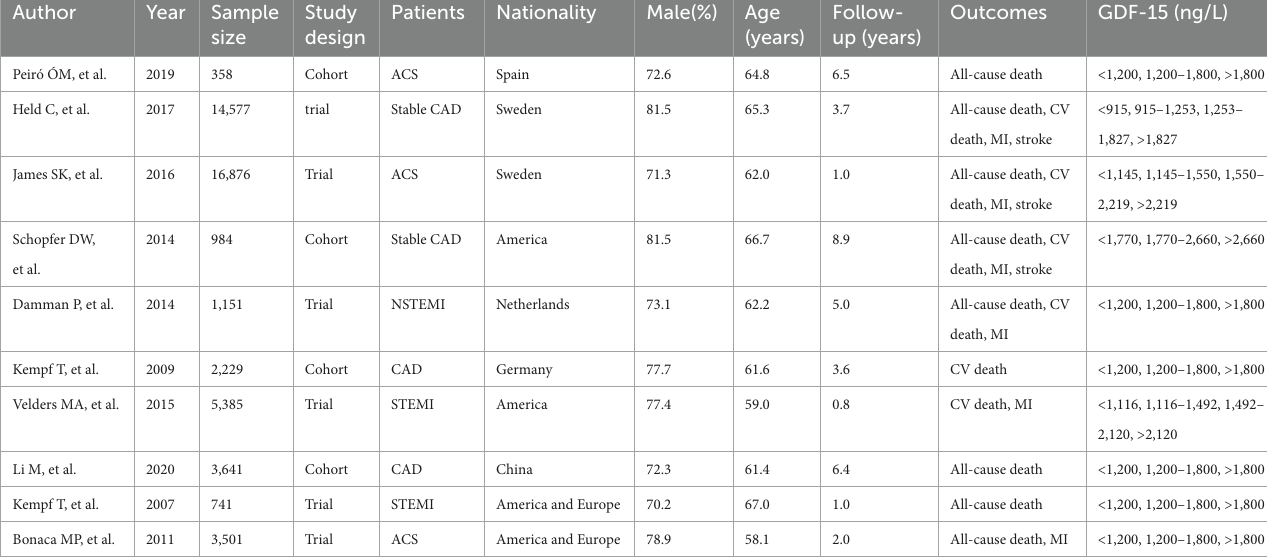
TABLE 1 Characteristics of studies included in the